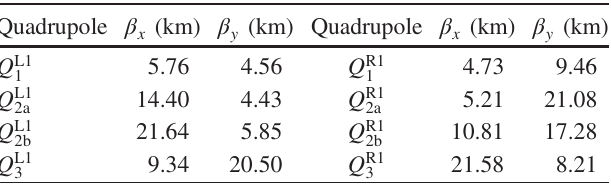
TABLE VI. The horizontal modulation depth of each circuit left (L1) and right (R1) of IP1 for 50 Hz and 600 Hz as computed from Eq. (1) and the parameters of Tables IV and